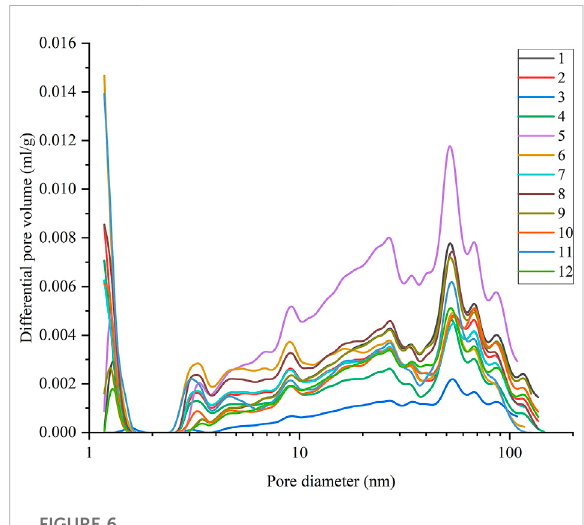
FIGURE 6 PSDs of shales estimated from N 2 adsorption